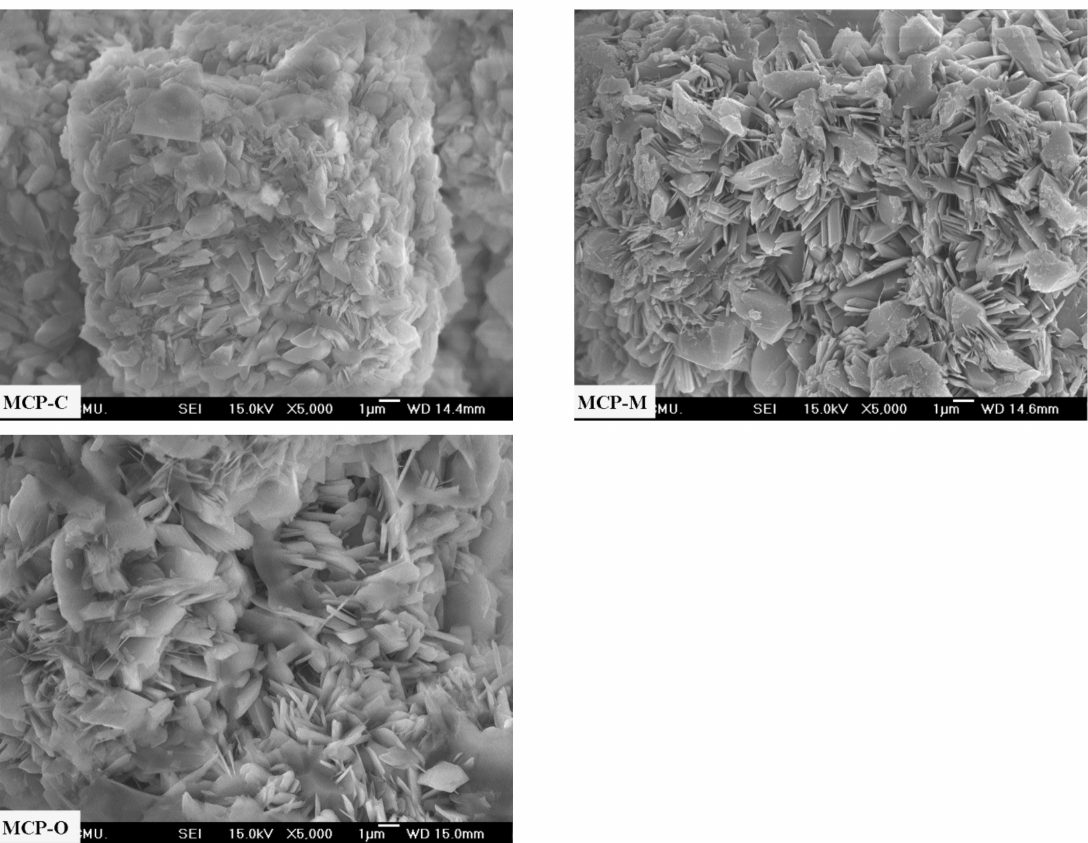
Figure 9. SEM micrographs of MCP-C, MCP-M and MCP-O